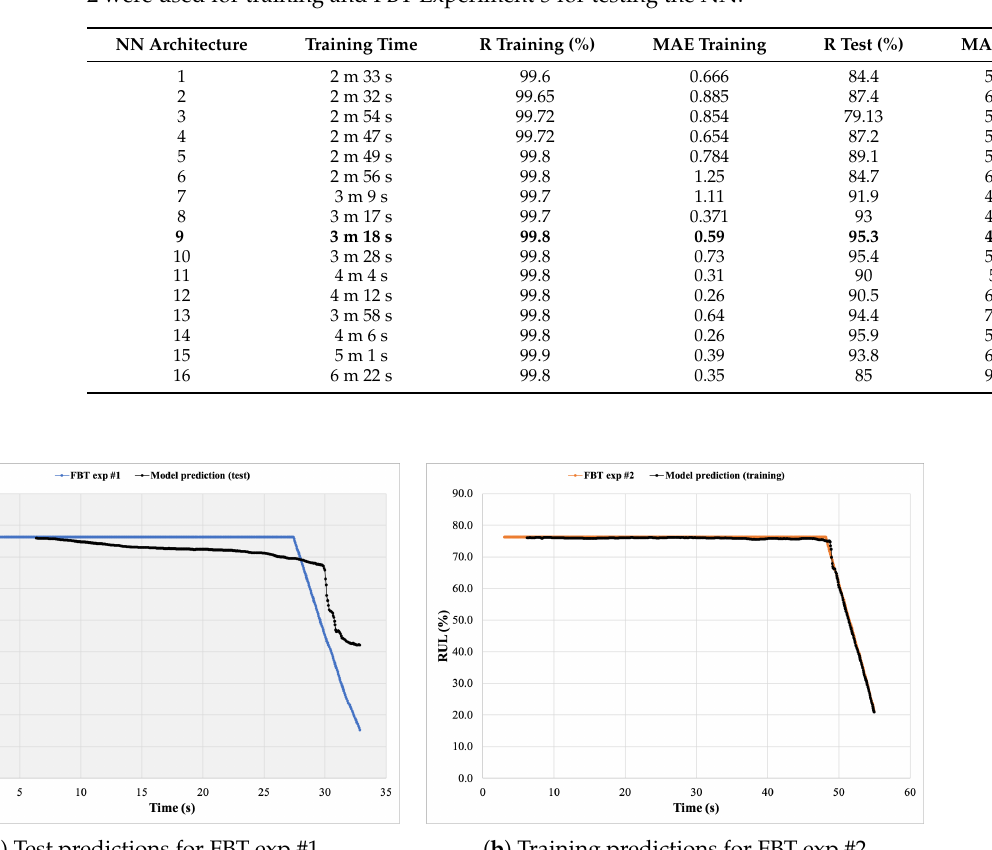
Table 3. Performance of the various NN architectures mentioned in Table 2. FBT Experiments 1 and 2 were used for training and FBT Experiment 3 for testing the NN.